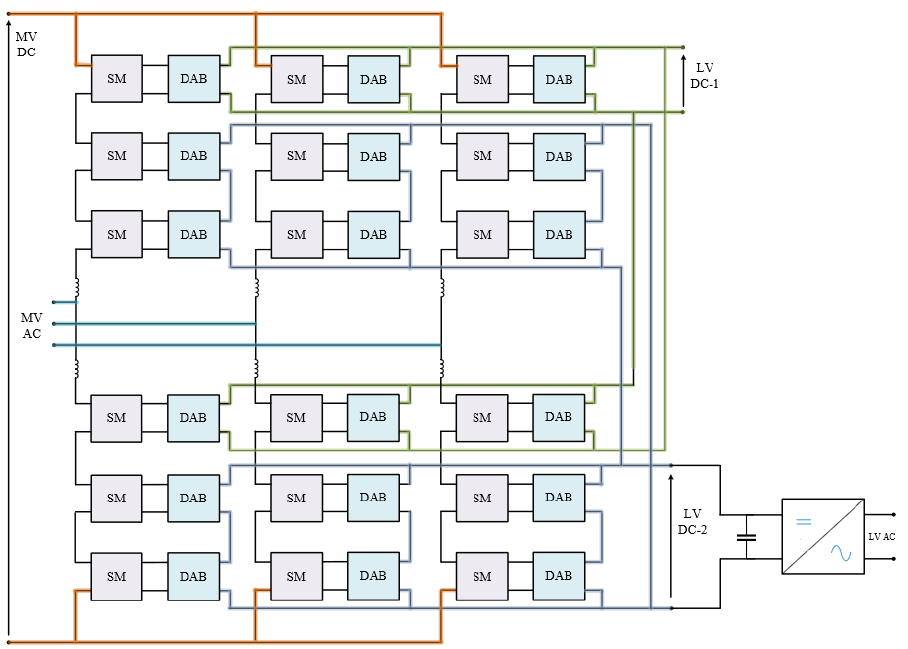
Figure 5. Four-port MMC-based multi-port solid-state transformer.